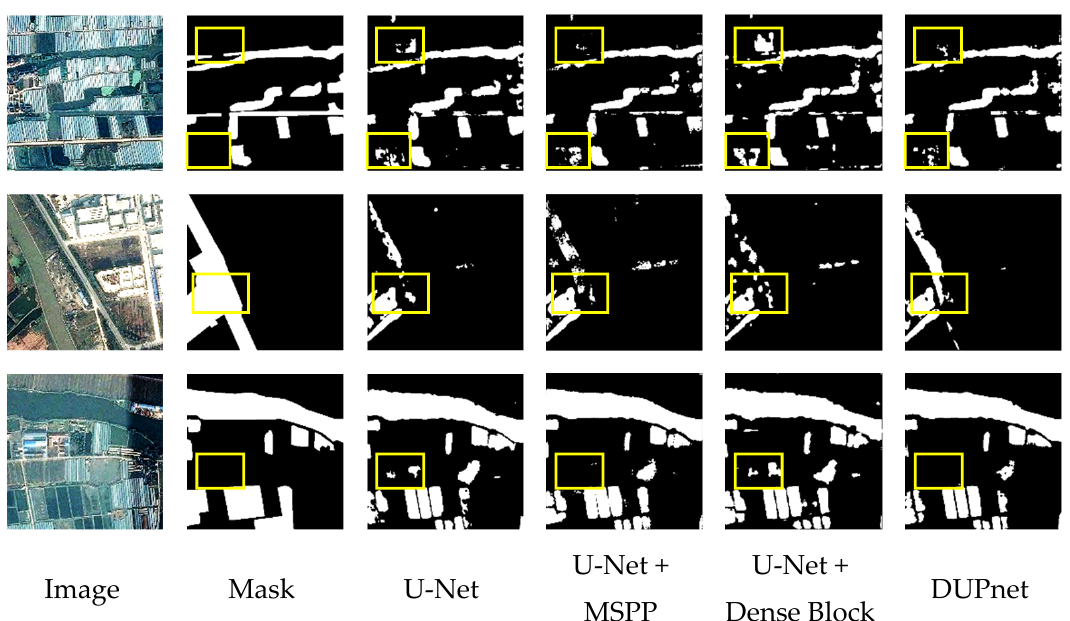
Figure 7. Visualization of extraction results of water bodies for ablation studies on the 2020 Gaofen challenge water body segmentation dataset.